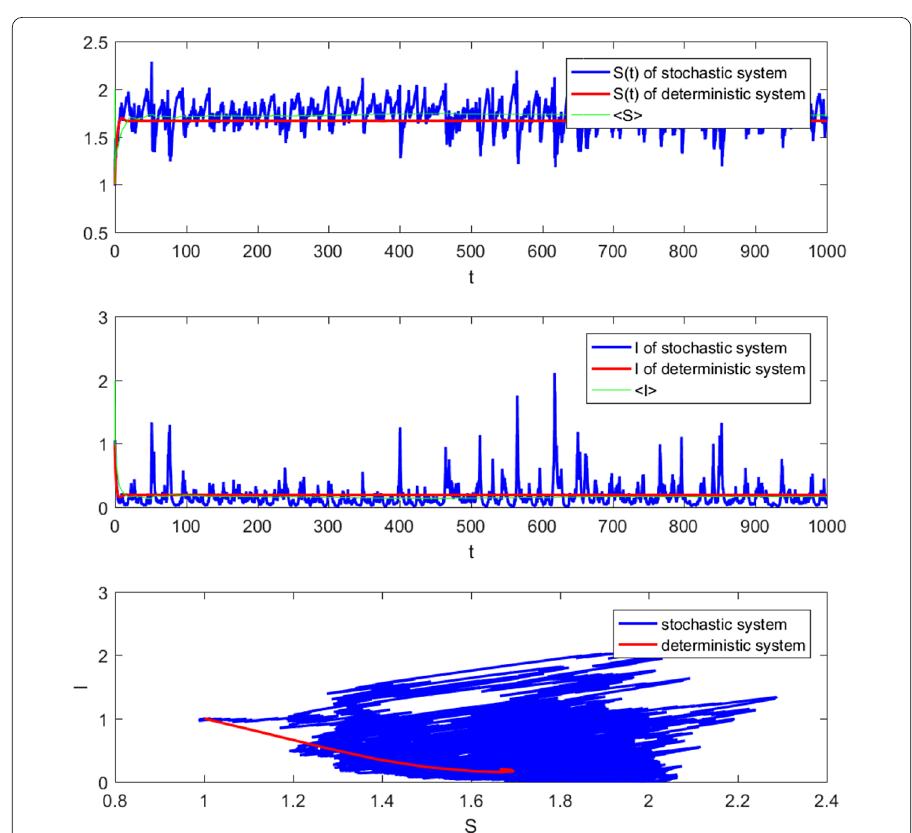
Figure 5 Comparison illustration for S ( t ), I ( t ) of deterministic system and stochastic system with σ = 0.1, Λ = 0.45, μ = 0.2, β = 0.5, γ = 0.79, α = 0.4, p = 2, where R = 1.8210 > 1, R ∗ = 1.7289 >